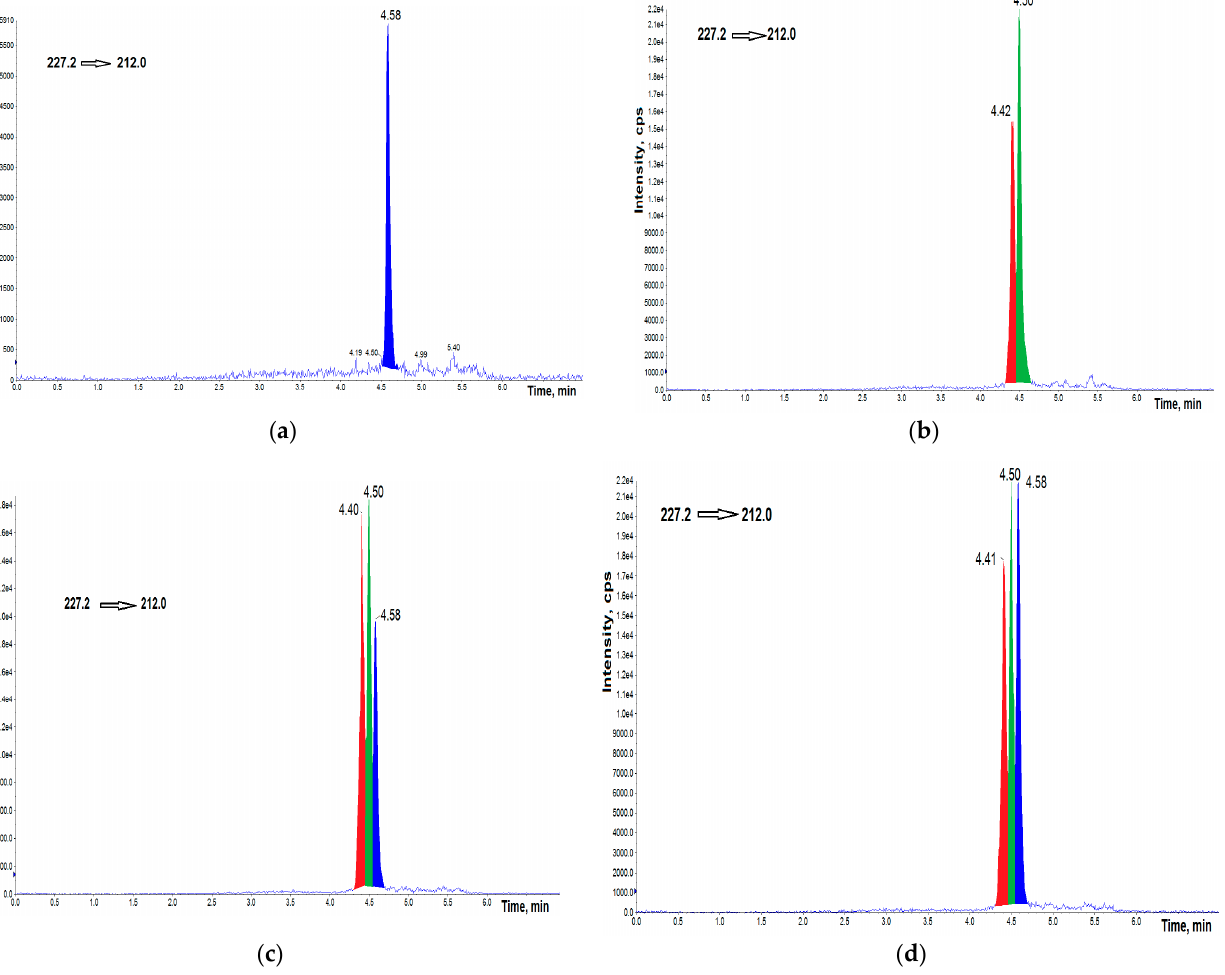
The raw data for the male/female cataract subjects with/without coexisting oph- thalmic pathology is presented in Supplementary Table (Table S1). Around 40% of collected whole AH samples contained detectable BPA-1 (red) and BPA-2 (green) (Table 5). More precisely BPA was detected in 12 AH samples (27.27%), with mean concentrations